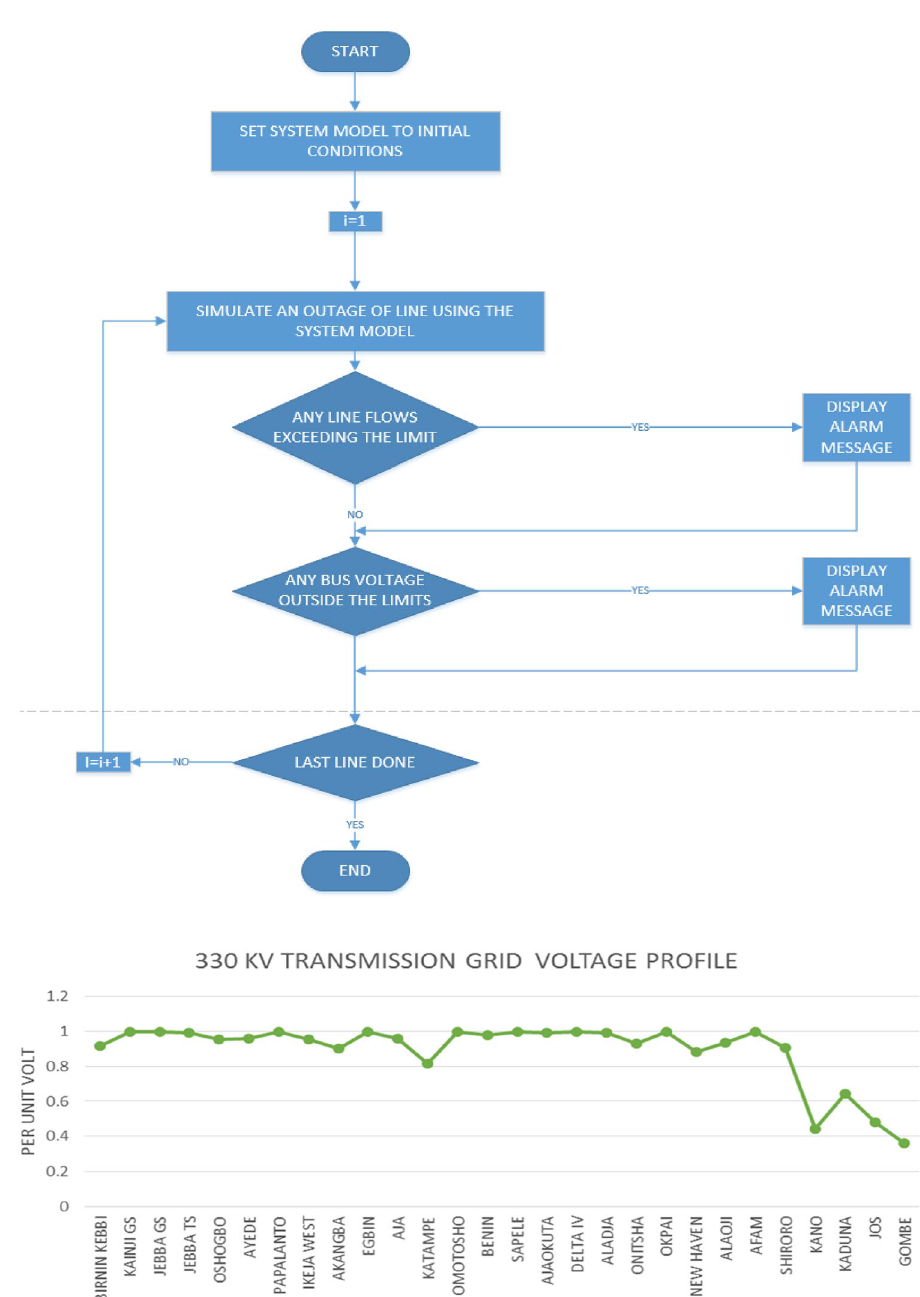
Fig. 6 Contingency analysis flow-chart